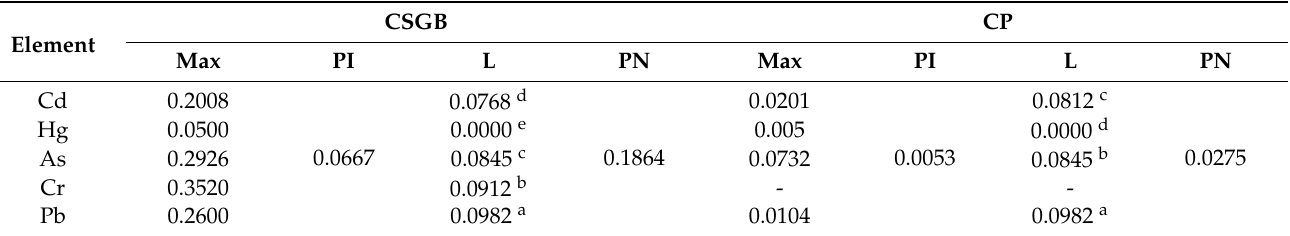
Table 4. The evaluation of heavy metal pollution